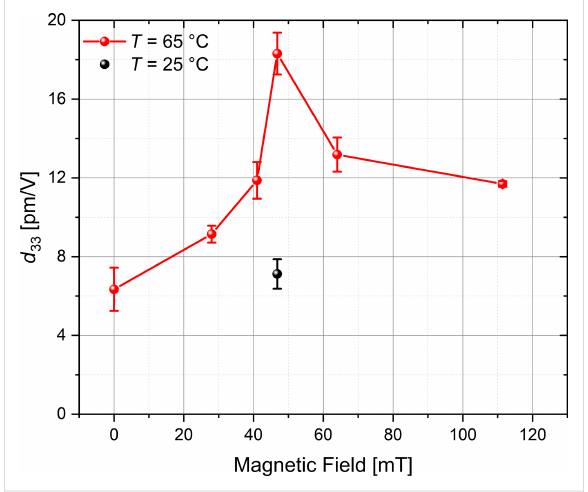
Figure 3: Value of d 33 of nanocomposites with 5 wt % of CoFe 2 O 4 as a function of the DC magnetic field strength applied for 1 h. The black point represents the value of d 33 when the DC magnetic poling was performed at room